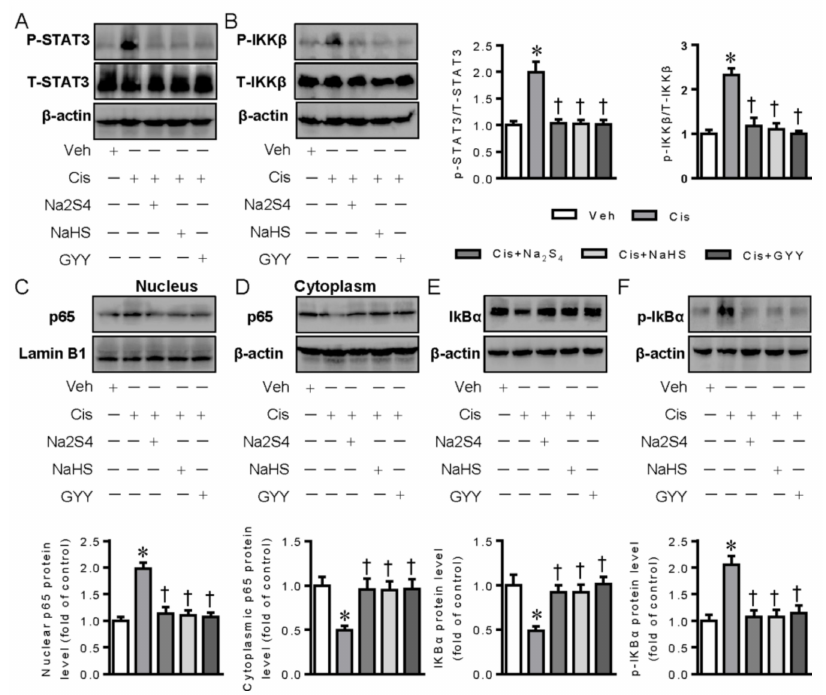
Figure 6. Polysulfide and H 2 S attenuated the activation of STAT3 and IKK β in mice after cisplatin treatment. ( A ) Representative blots of P-STAT3. ( B ) Representative blots of P-IKK β . ( C ) Representative blots of nuclear p65 NF- κ B. ( D ) Representative blots of cytoplasmic p65 NF- κ B. ( E ) Representative blots of I κ B α . ( F ) Representative blots of P-I κ B α . * p < 0.05 vs. Vehicle (Veh), † p < 0.05 vs. Cisplatin (Cis). GYY4137 (GYY). n = 5 in each